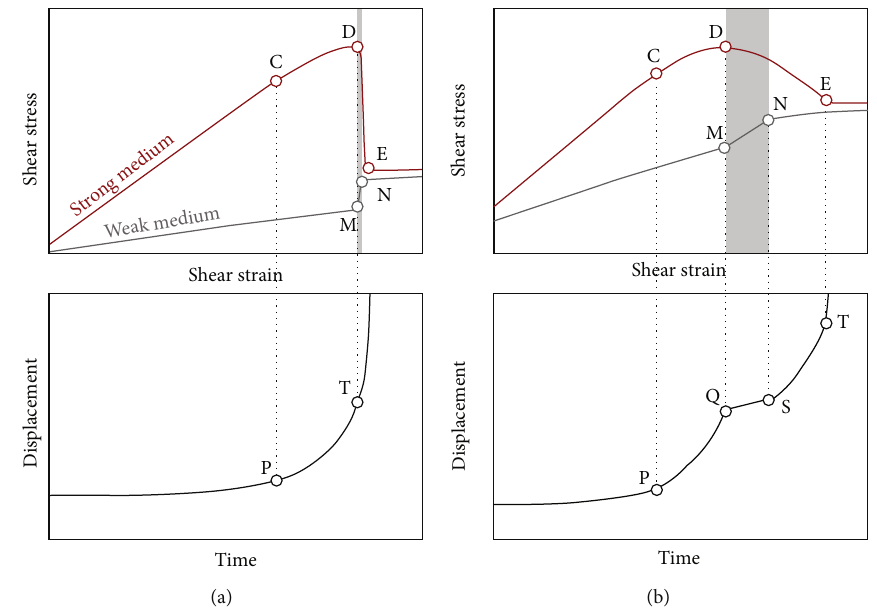
Figure 4: Shear stress − strain and displacement − time relations corresponding to (a) rapid and (b) slow unlocking-induced startup mechanisms. Points C, D, and E denote the volume-expansion, peak-stress, and residual-strength points of the locked segments, respectively. Points M and N denote the onset and termination, respectively, of the resistance homogenization process (gray shaded area). Points P and T denote the startups of displacement acceleration and landslide, respectively. In (b), points Q and S denote the suspension and resumption of displacement acceleration,